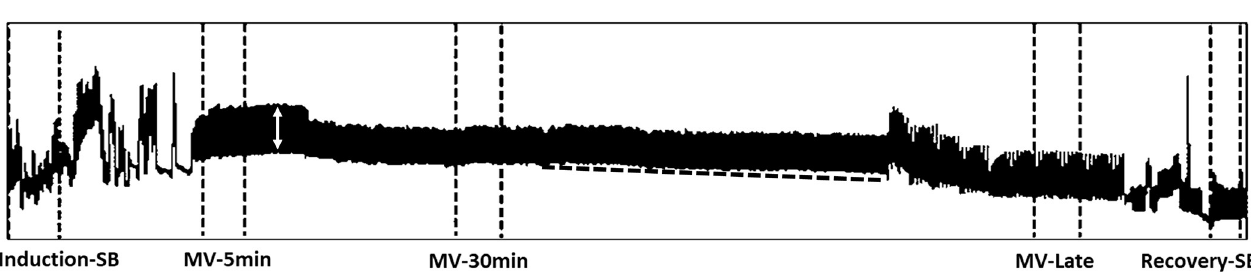
Fig 1. Plethysmogram representing the total monitoring time with EIT. The white tracing represents the variation in ventilation over time. Delta Z (double arrow) represents the tidal variation in impedance and is associated with tidal volume. The vertical dashed lines indicate the periods studied during monitoring: induction-SB (spontaneous breathing before anesthesia induction), MV-5min (initial five minutes of controlled ventilation), MV-30min (after 30 minutes of controlled ventilation), MV-late (final 5 minutes of controlled ventilation) and recovery-SB (after removal of the artificial airway and resumption of spontaneous